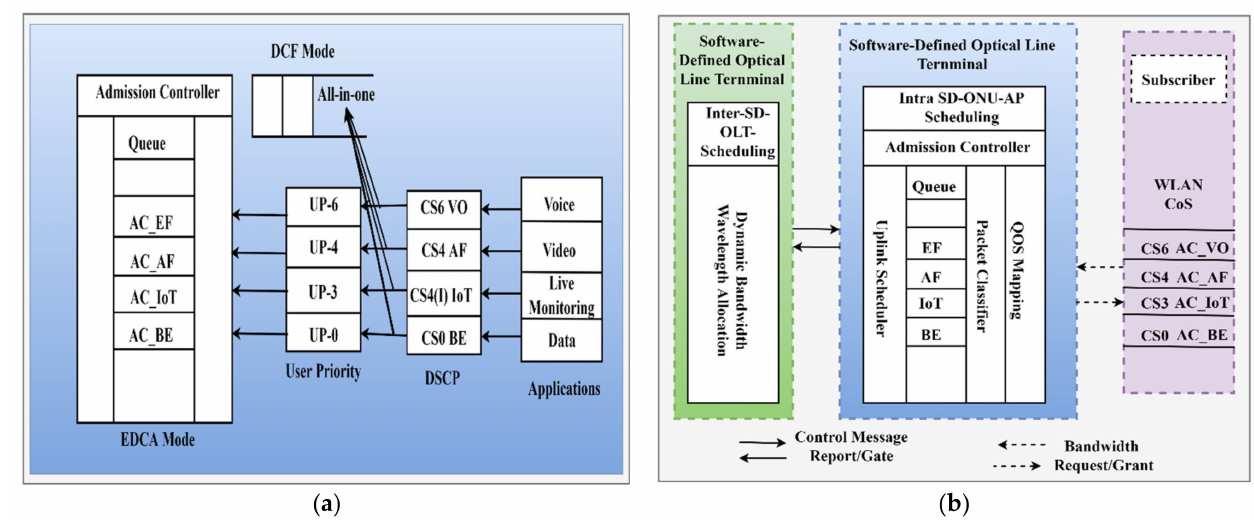
Figure 4. ( a ) Packet classification WiFi-STA ( b ) Packet classification of